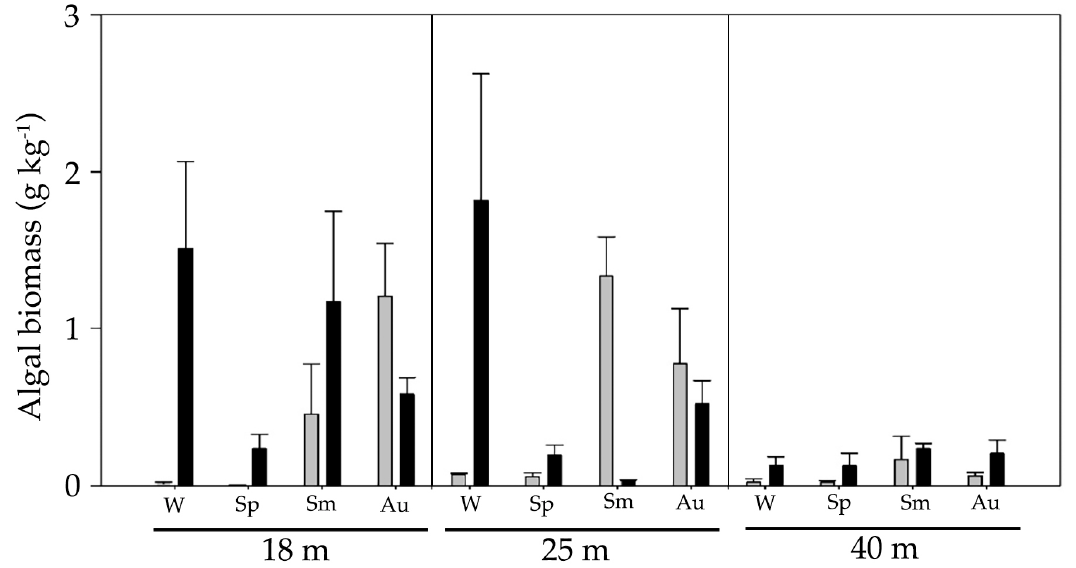
Figure 2. Total epiphytic algal biomass (dry weigh) (+ SE of means) at different depths (18, 25, and 40 m) and seasons (W: winter, Sp: spring, Sm: summer, Au: autumn) from 2015–2016 (grey bars) and 2017 (black bars). Data from [26].